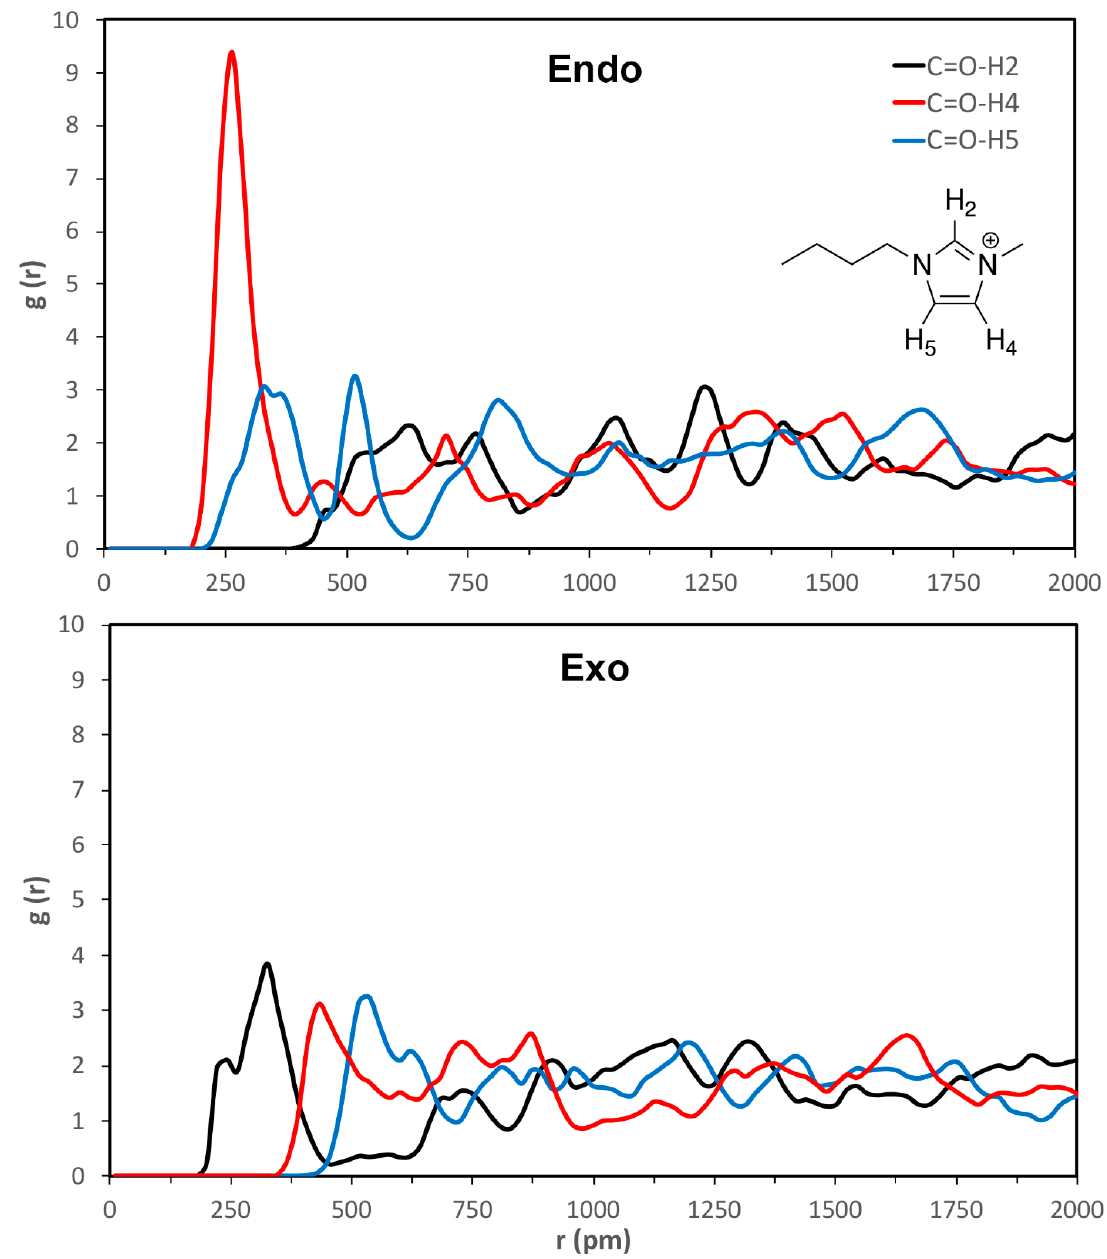
Figure 3. Radial distribution functions for the endo (top) and exo (bottom) transition states in the cyclopentadiene and methyl acrylate reaction in [BMIM][PF 6 ] at 25 °C using the OPLS-VSIL force field between the ring protons on BMIM and carbonyl oxygen of methyl acrylate.